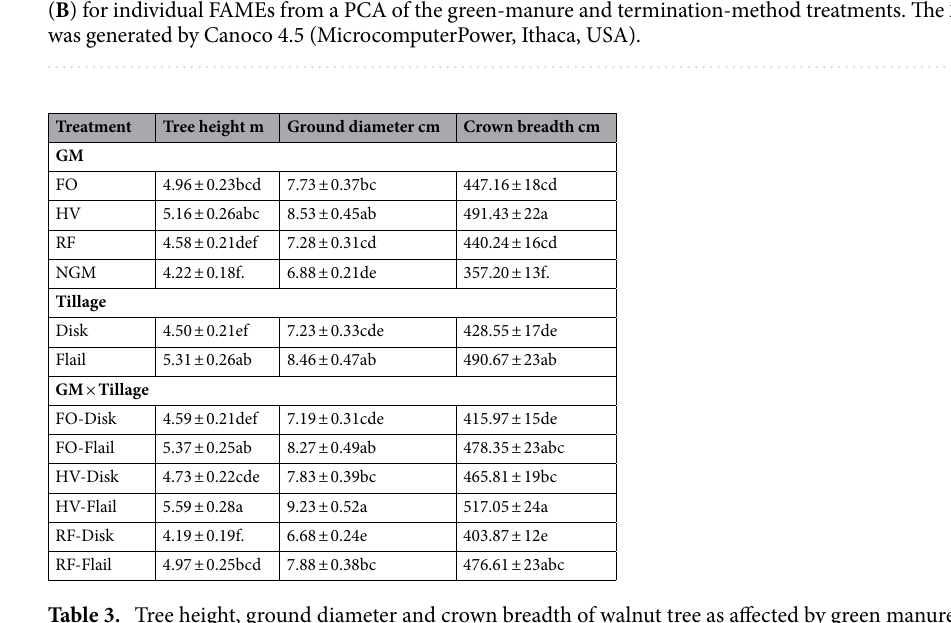
Table 3. Tree height, ground diameter and crown breadth of walnut tree as affected by green manure and termination method. The values are means ± standard deviations (n = 3). Values followed by different letters differ significantly (LSD test, P < 0.05). The P values of ANOVA are shown in Table S5. GM green manure; FO february orchid; HV hairy vetch; RF rattail fescue; NGM no green manure.